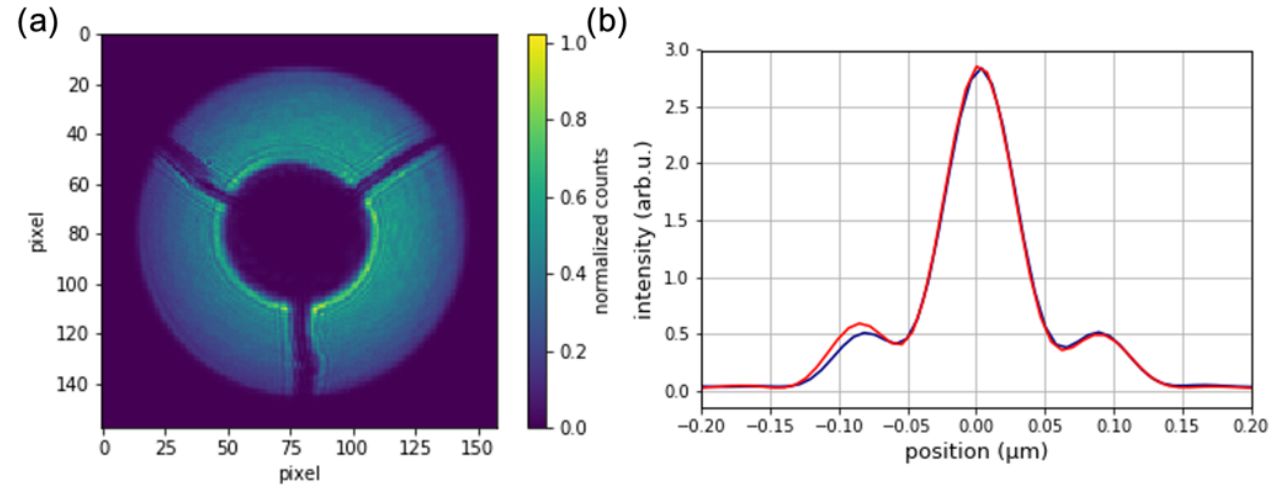
Figure 5. ( a ) First order diffraction cone of a fabricated zone plate with 60 nm outermost zone width. The round disk with three support bars in the center is the central stop. ( b ) Focal spot profile in horizontal (blue) and vertical (red) direction reconstructed by ptychography. The full width at half maximum size is 60 nm × 60